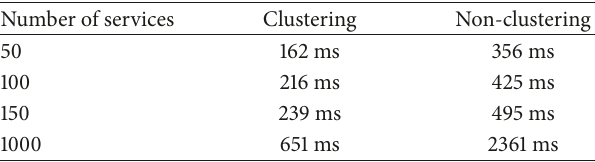
Table 2: Comparison results of response